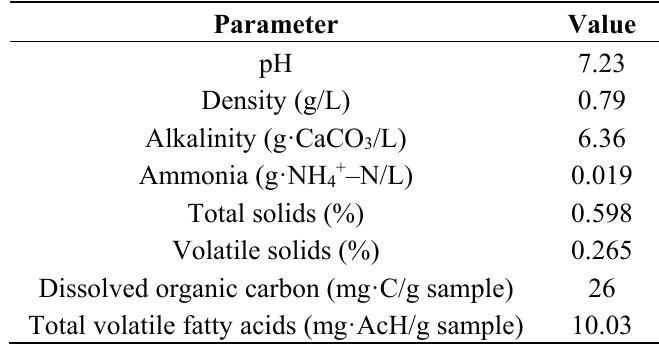
Table 4. Physico-chemical characterization of the organic fraction of municipal solid waste.